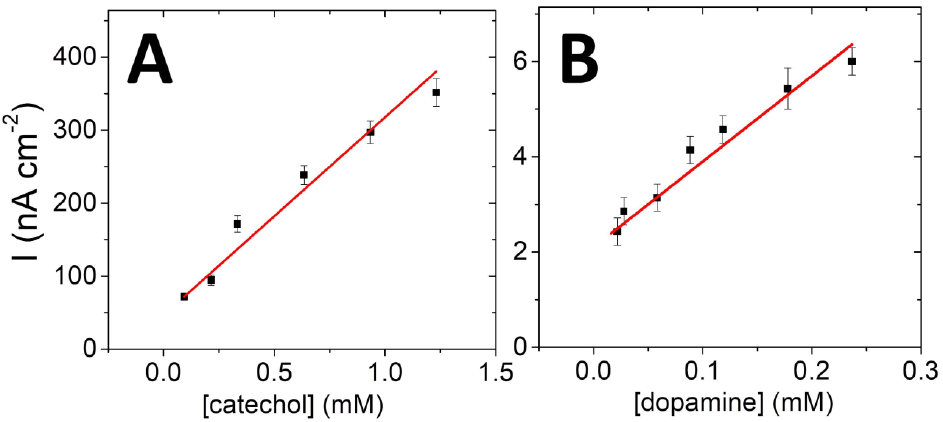
Figure 6. Plot of the linear part of the catalytic current density towards concentration of ( A ) catechol and ( B ) dopamine (E applied = − 0.2 V vs. SCE, 0.1 M PBS, pH 6, 25 °C).